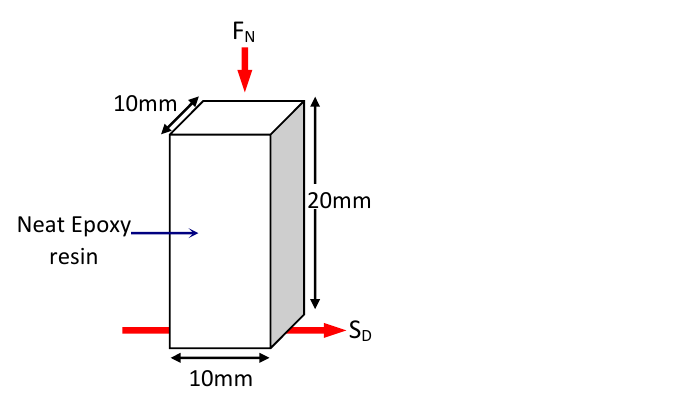
Figure 3. Schematic illustration of the Stalked Bamboo Fibre Reinforced Epoxy (S-BFRE) composite test specimen. Note : FN—Applied Normal Load; SDSliding Direction.